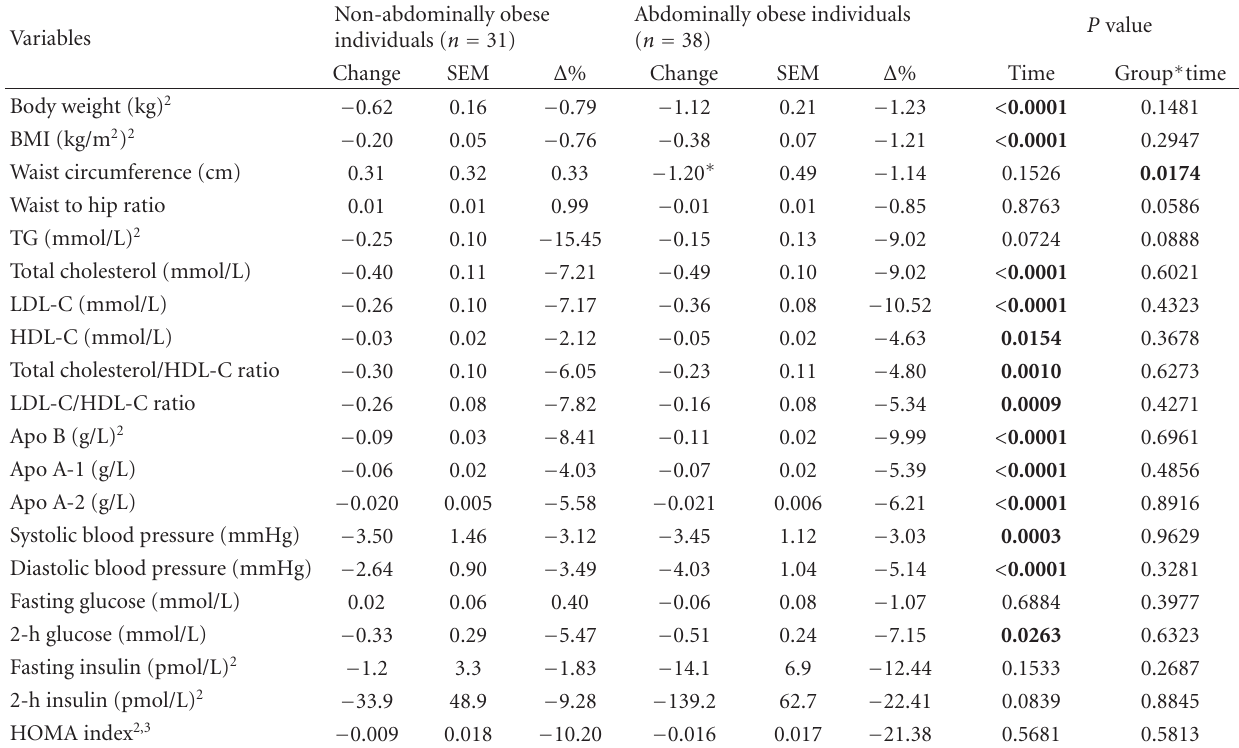
Table 5: E ff ects of the 4-week controlled Mediterranean diet intervention on anthropometric and metabolic variables associated with cardiovascular risk in abdominally obese and non-abdominally obese individuals 1